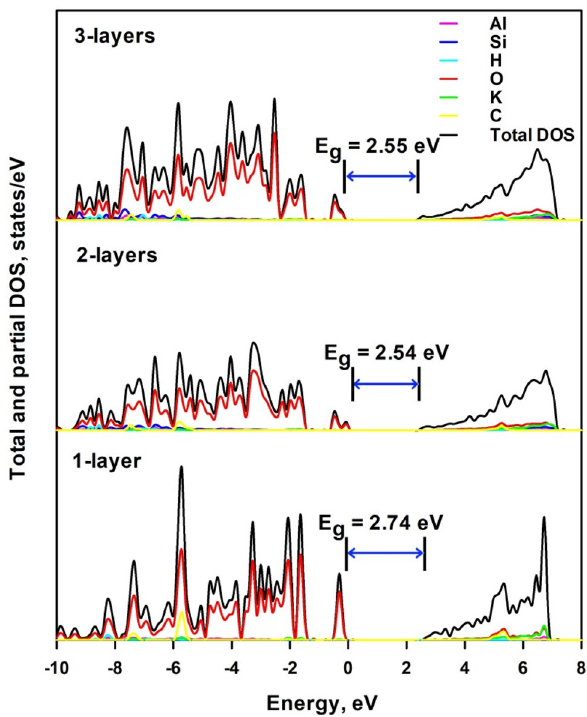
Figure 9. Total and projected density of electronic states of mica nanosheets-K 2 CO 3 composite